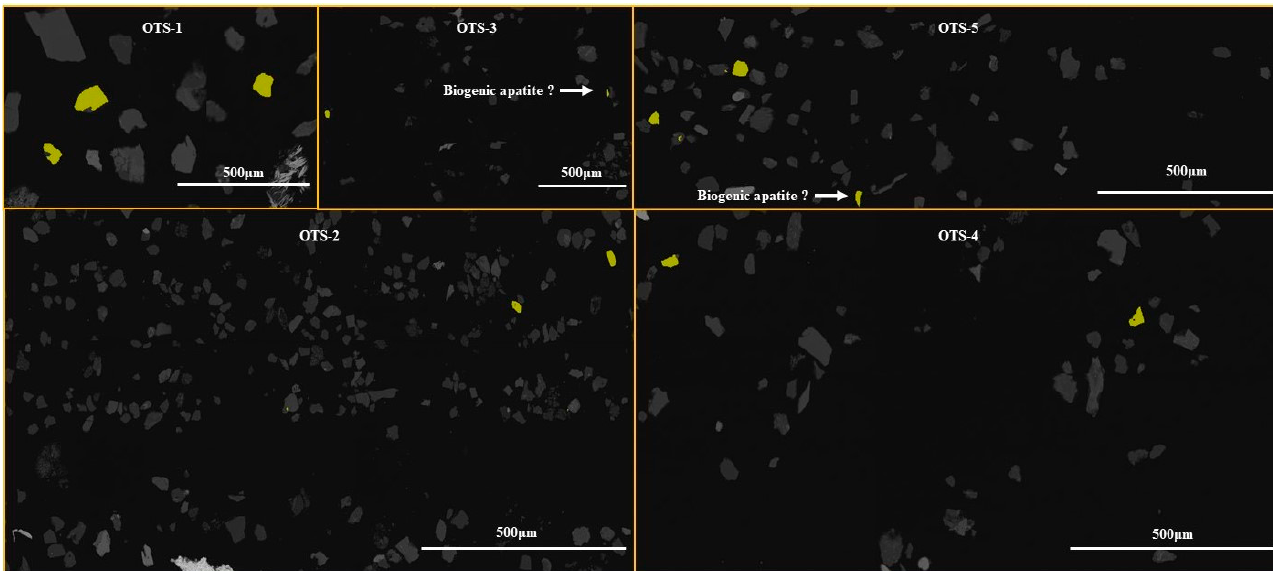
Figure 4. BSE map of apatite in H4-S2. Apatite grains were marked yellow in this map.